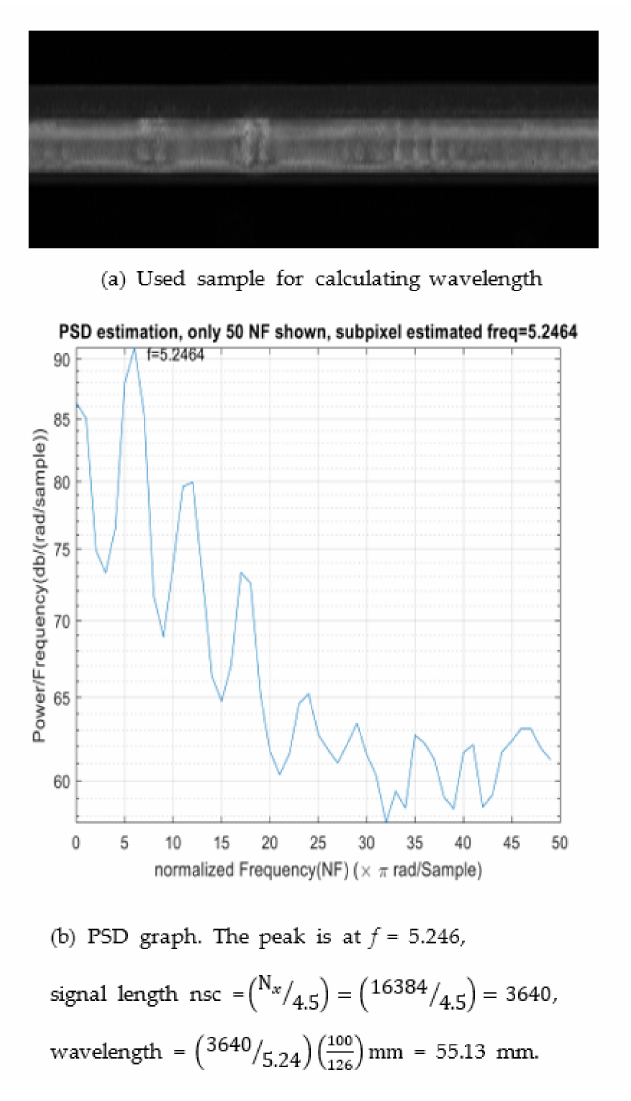
Figure 12. Visualization of Frequency Estimation using Power Spectrum. Table 4. Wavelength and subpixel frequency estimation of different testing